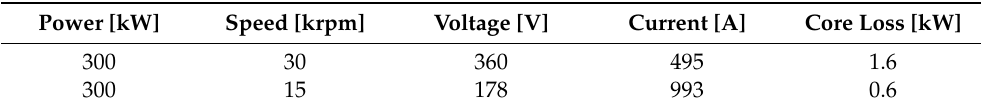
Table 4. Characteristics in power generation